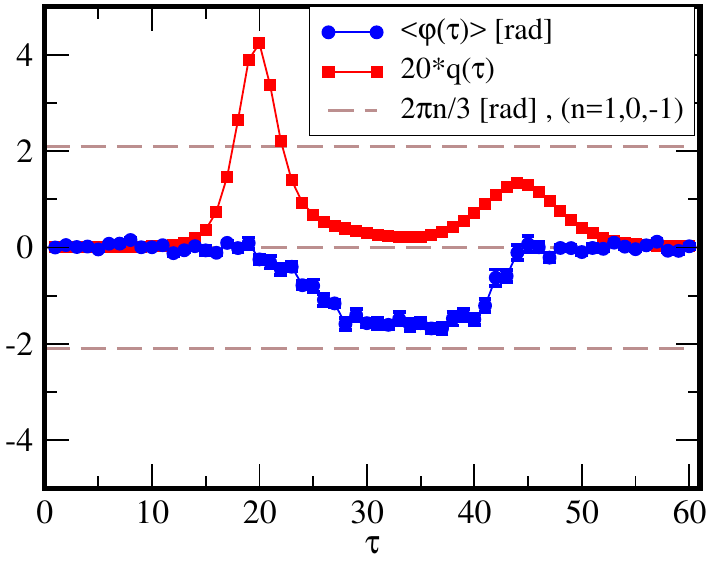
Figure 9 . (cid:28) -dependence of the averaged complex phase (blue-circle) and the local topological charge (red-square) for